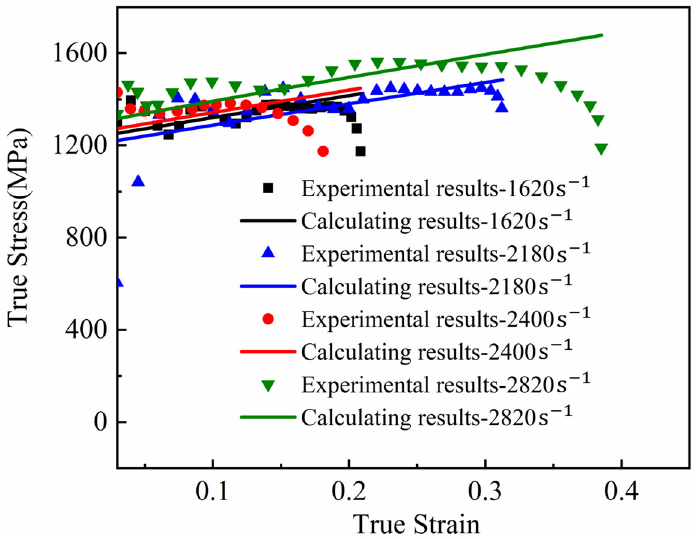
Figure 7. Comparison of the experimental results with the J−C constitutive equation calculations for the Ti−6Al−1Mo−2Zr−0.55Fe−0.1B alloy. the Ti-6Al-1Mo-2Zr-0.55Fe-0.1B